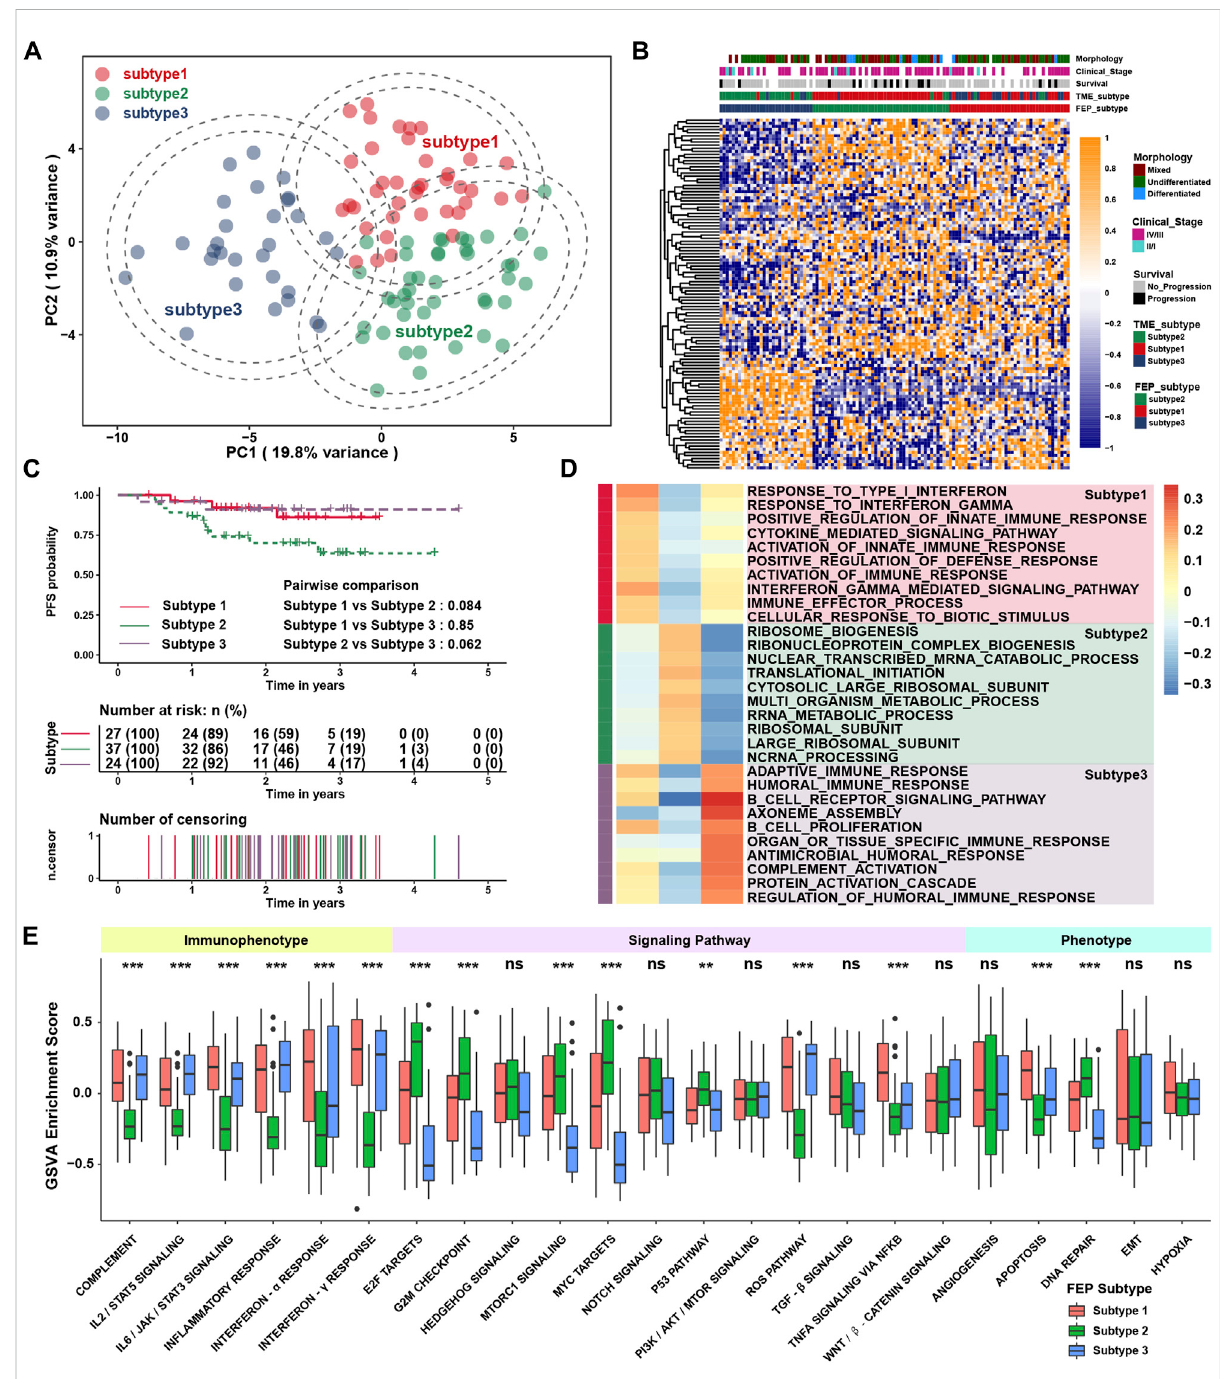
FIGURE 1 Identi fi cation of ferroptosis regulatory patterns and biological function analysis. (A) The transcriptome pro fi les of ferroptosis subtypes using principal component analysis. (B) Heatmap of ferroptosis regulators among ferroptosis subtypes. Morphology, clinical stage, survival, and TME subtype were used as patient annotations. (C) Survival analysis among ferroptosis subtypes in GSE102349. (D) GSEA revealed distinct enriched gene sets among subtypes. Rows were de fi ned by gene sets, and columns by consensus scores for each subtype. (E) The GSVA enrichment score in pathways. Each box spans the interquartile range with the upper and lower end of the boxes representing the 25th and 75th percentile values. The horizontal lines in the boxes represented the median values. The black dots showed outliers. The asterisks represented p values (** p < 0.01; *** p < 0.001) and ns represented no signi fi